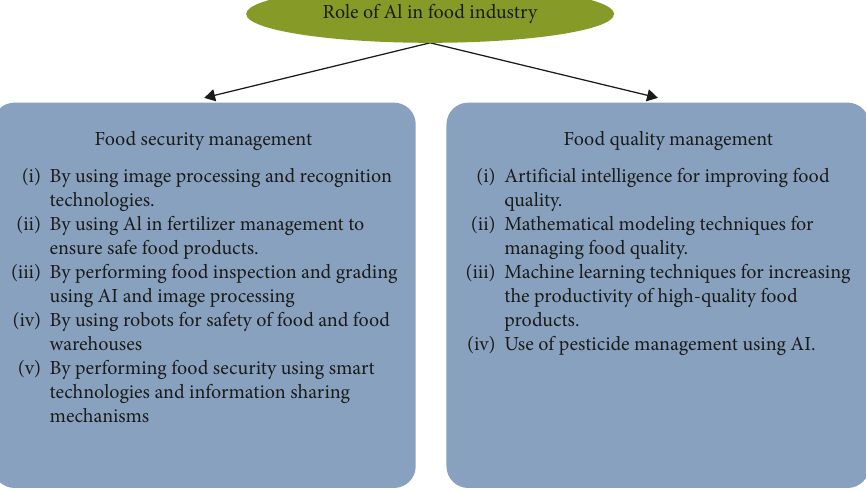
Figure 1: Role of AI in the food processing industry